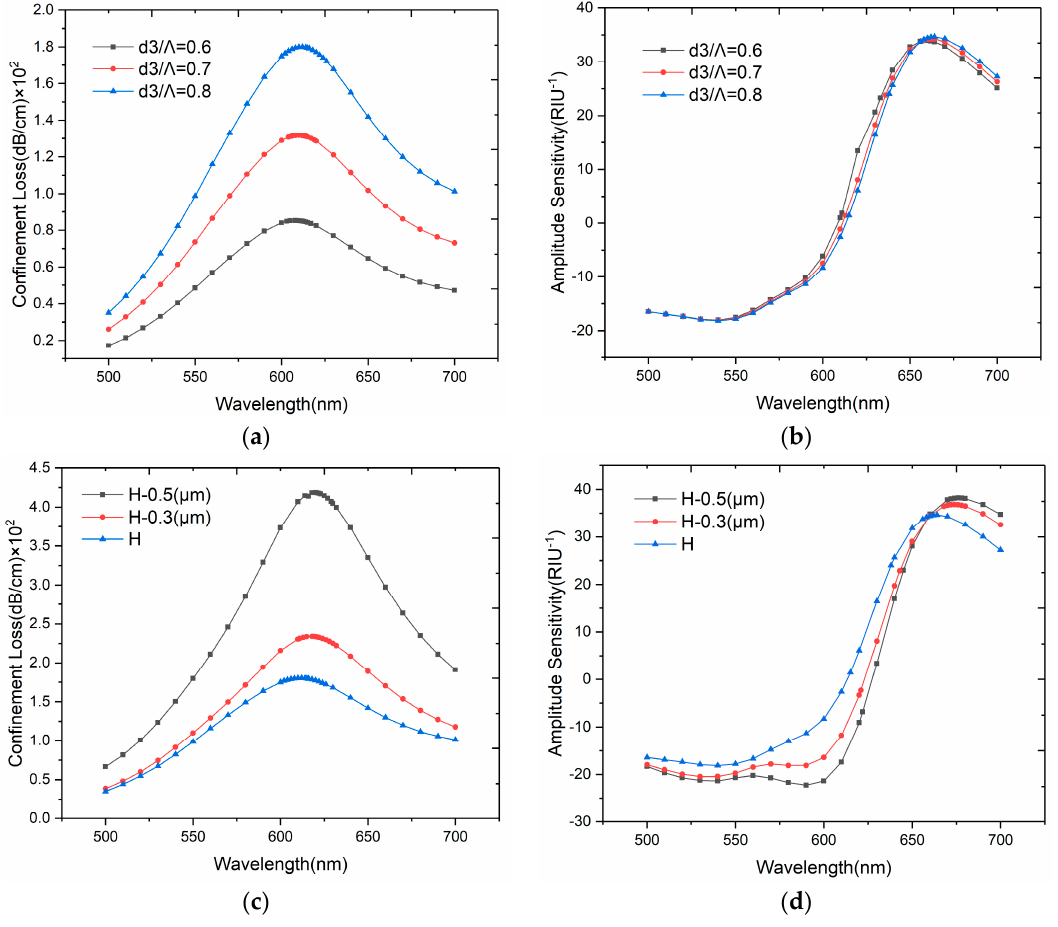
Figure 6. ( a ) Loss spectra of the designed sensor when d 3 / Λ = 0.6, 0.7 and 0.8 with n a = 1.33; ( b ) Amplitude sensitivities of the proposed sensor when d 3 / Λ = 0.6, 0.7, 0.8 with n a = 1.33; ( c ) Loss spectra of the designed sensor when H changed with n a = 1.33; ( d ) Amplitude sensitivities of the proposed sensor when H changed with n a = 1.33.